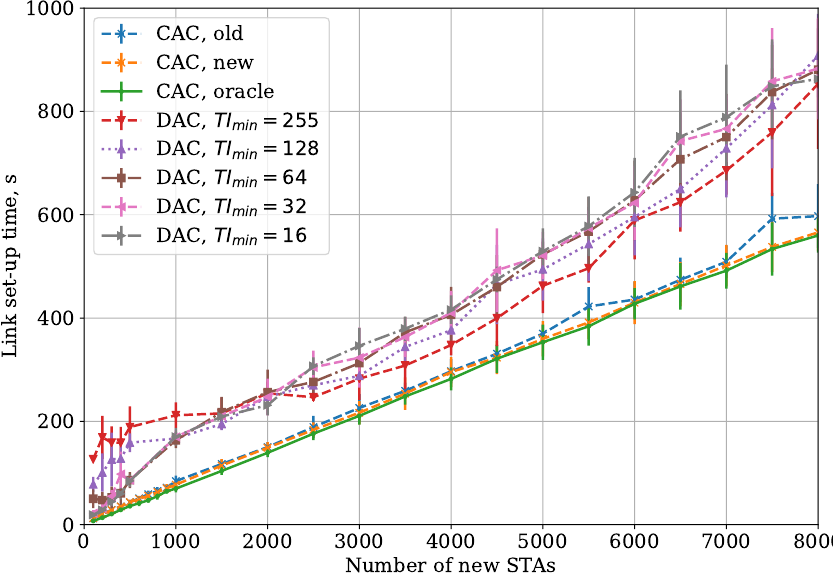
Figure 5. CAC and DAC protocols: dependency of the link set-up time on the number of new STAs for the Small Area